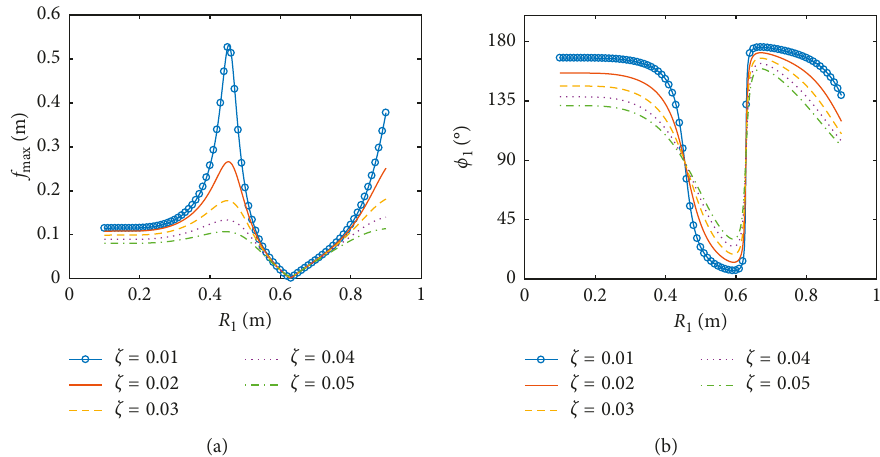
Figure 7: The amplitudes and the phases of the surface wave height versus the inner radius of the flexible baffle for z (a) the amplitude of the surface wave height, (b) the phase of the surface wave height.